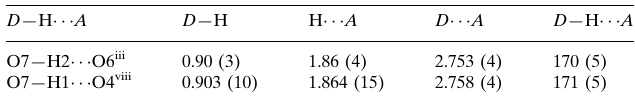
Hydrogen-bond geometry (A˚ , (cid:2)